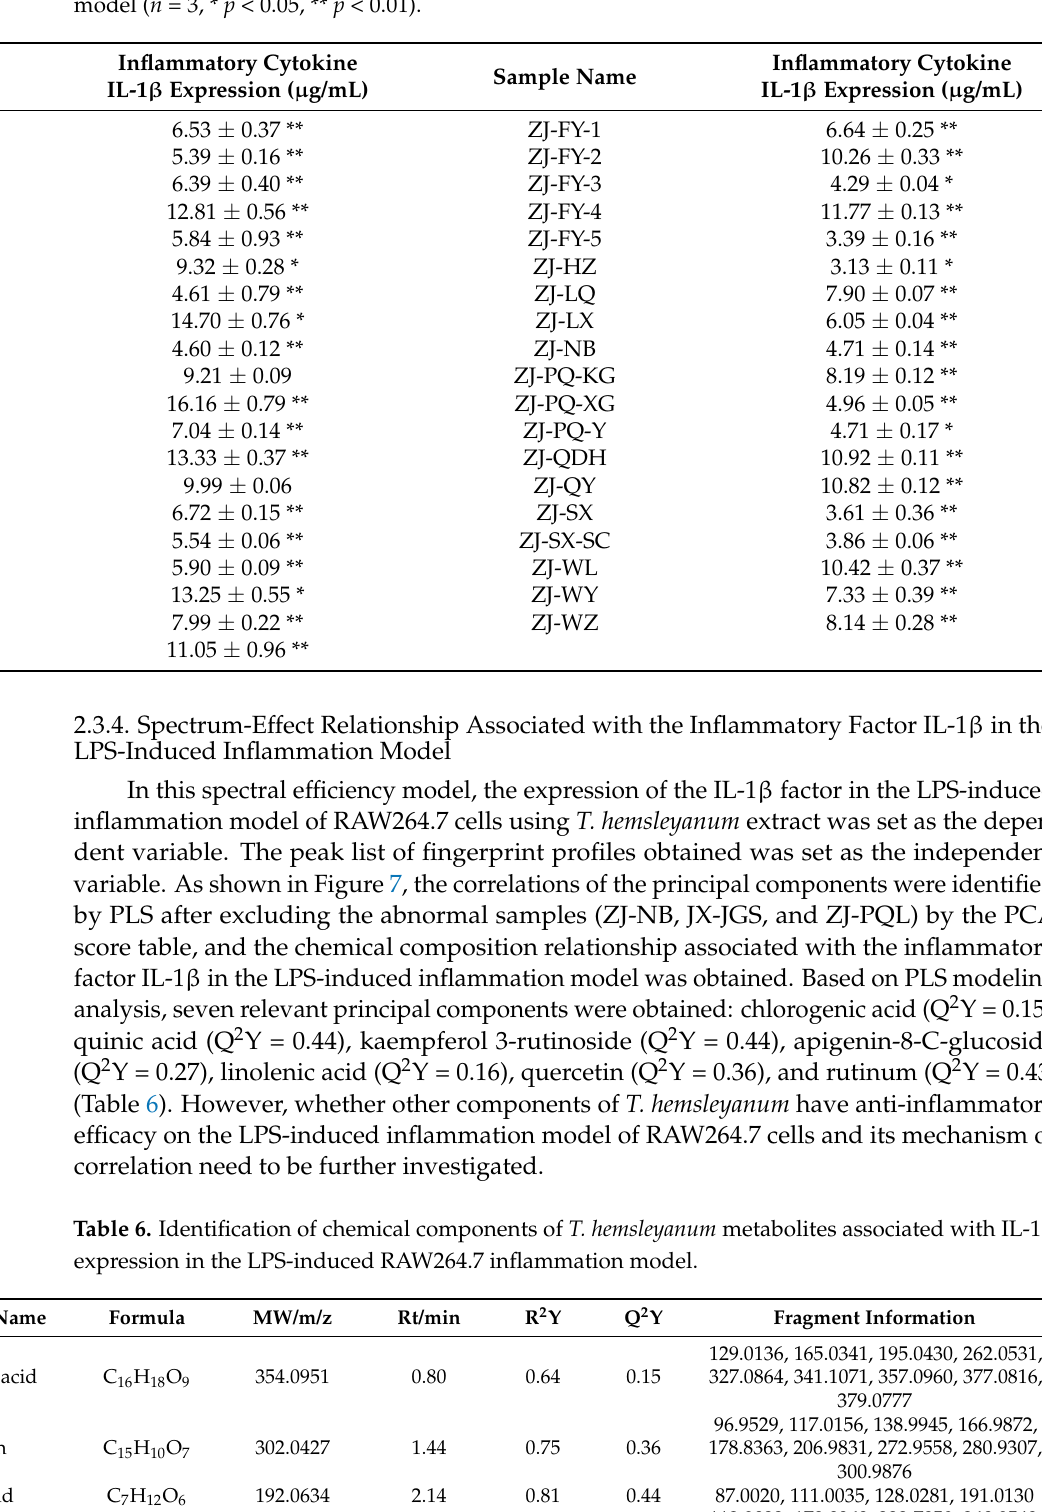
Table 5. Effect of T. hemsleyanum on IL-1 β expression in the LPS-induced RAW264.7 inflammation model ( n = 3, * p < 0.05, ** p < 0.01).